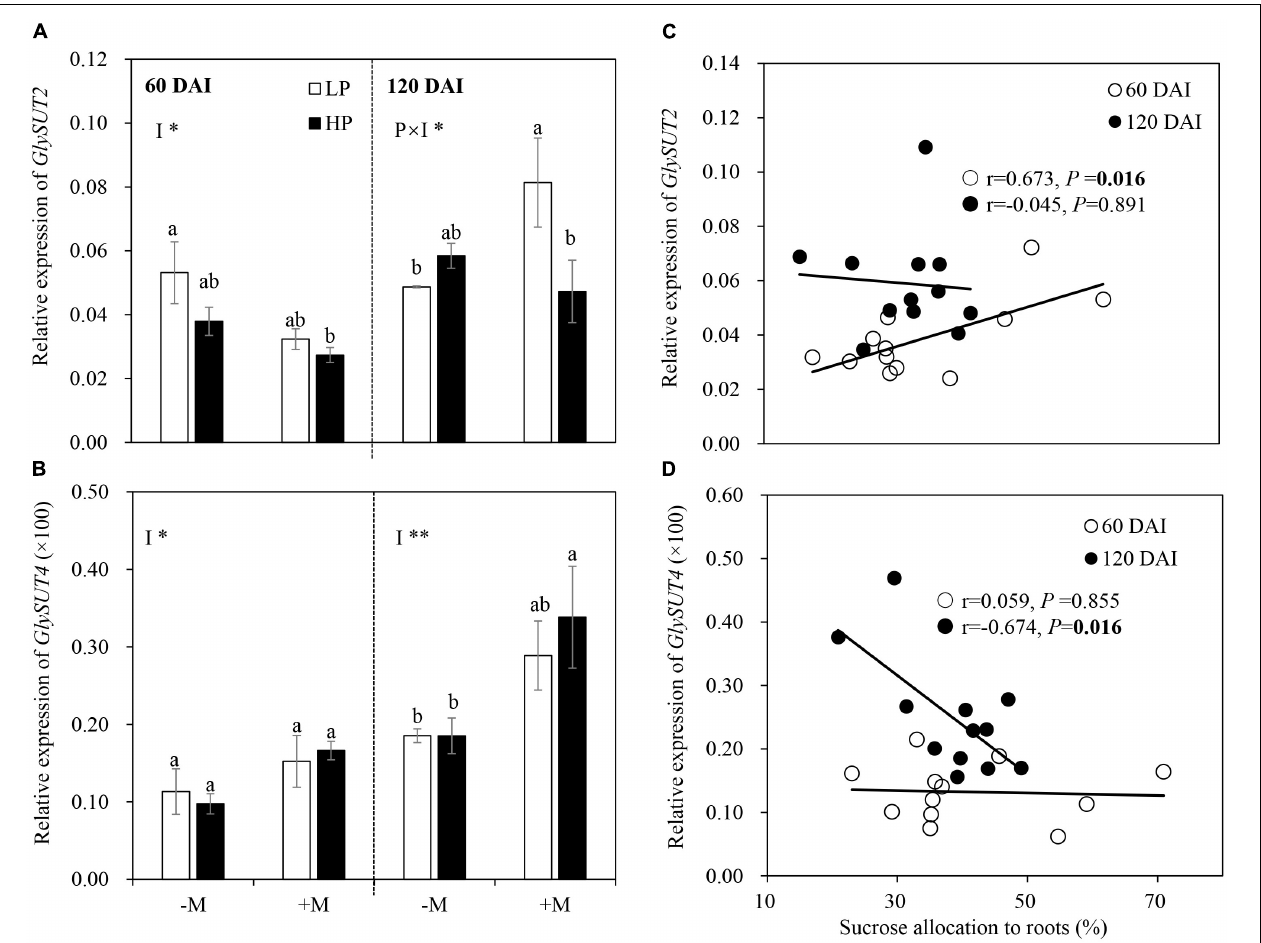
FIGURE 6 | Relative expression of (A) GlySUT2 and (B) GlySUT4 as affected by soil P levels (P) and mycorrhizal status (I) 60 and 120 days after inoculation (DAI). –M and +M represent non-AM and AM inoculation with R. irregularis , respectively. LP and HP represent 30 and 170 mg kg − 1 P application, respectively. Data are presented as mean ± standard error (SE, n = 3). Treatment effects were tested by two-way ANOVA separately between the two harvests. ∗ P < 0.05; ∗∗ P < 0.01. Multi-comparison was performed across all treatments at the same harvest time, and the same letter indicates no significant difference between the means at P < 0.05 by Turkey’s HSD test. Sucrose allocation to roots in relation to the relative expression of genes (C) GlySUT2 and (D) GlySUT4 at two harvests separately. Pearson correlation analyses were conducted to check the